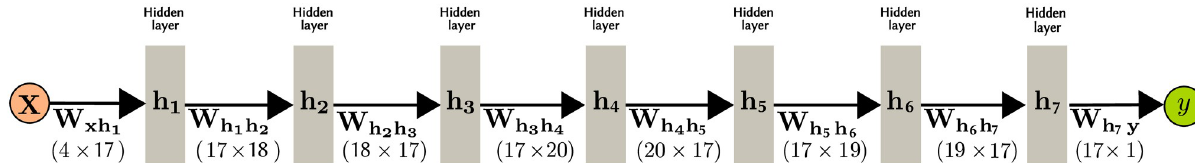
Fig 3. Deep Neural Network model forecasting satisfaction with telemedicine. W to layer j . The dimension of each weight matrix is give in ().